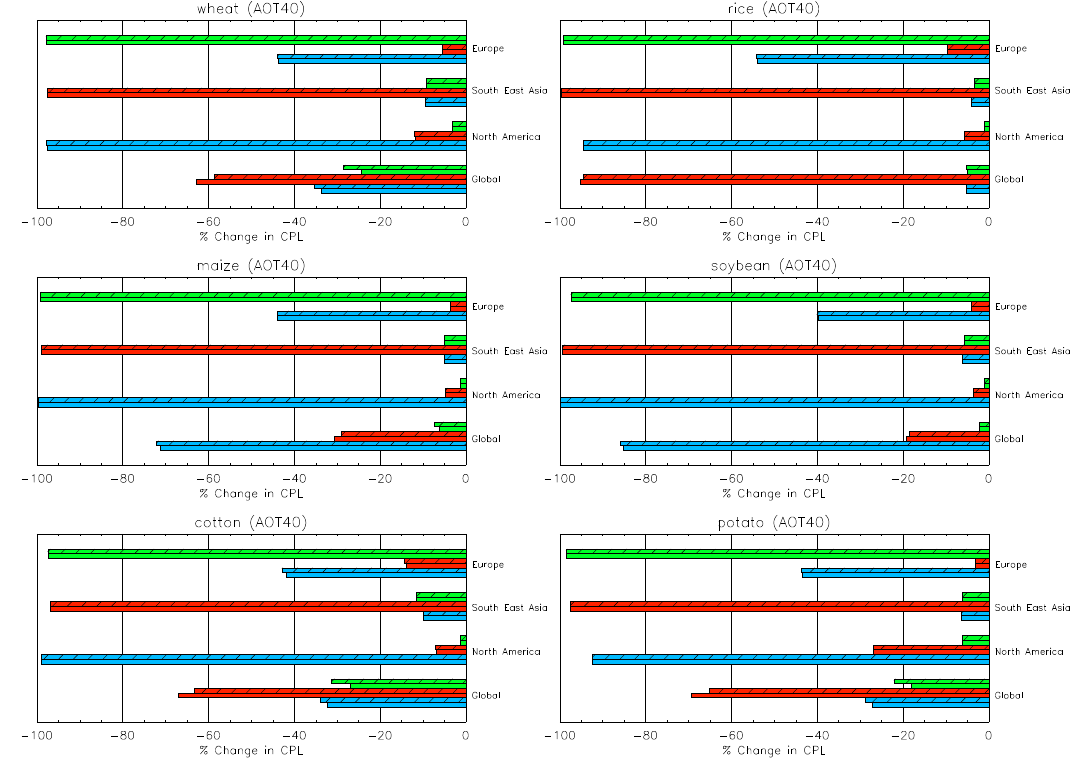
Fig. 10. Percentage reductions in ozone-induced crop production loss for the 6 crops considered (based upon the AOT40 exposure index) resulting from 100% regional cuts in anthropogenic NO x emissions. The y-axis shows the receptor regions, and coloured bars indicate the impacts from emission cuts applied in each region compared to the control model (Green=European emission cut, Red=SE Asia emission cut and Blue=N America emission cut). Solid colour bars show results based on the standard model metric and hatched bars show results based on the bias-corrected model metric (see main text for details).